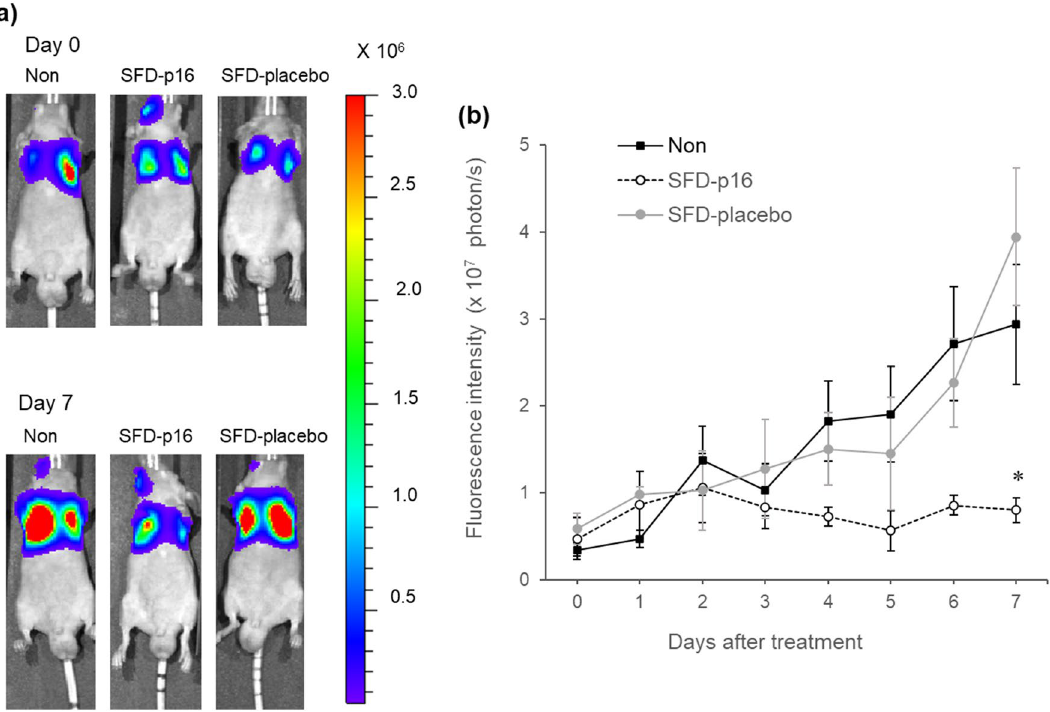
Figure 4. Tumor-suppressive effects of SFD-p16 in the orthotopic lung cancer model in vivo test. ( a ) Optical images of lung luminescence corresponding to firefly luciferase activity in mice bearing A549/Luc cells with no treatment or treated with SFD-p16 or SFD-placebo. A549/Luc cells were intravenously injected into the retro- orbital venous sinus at day 0. The luminescence corresponding to firefly luciferase activity was detected using IVIS. SFD-p16 and SFD-placebo were intratracheally insufflated at a dose of 0.5 mg/mouse. The color scales are in photons/s/cm 2 /sr. ( b ) Time course of lung luminescence intensity corresponding to firefly luciferase activity in mice bearing A549/Luc cells with no treatment (the solid line) or treated with SFD-p16 (the dotted line) or SFD-placebo (the gray line). Each value represents the mean ± SE (n = 5–12). Homogeneity of variance was determined by Levene’s test. Between-group statistical differences were compared using Dunnett’s test. (* p < 0.05 compared with Non). Non: no treatment; SE: standard